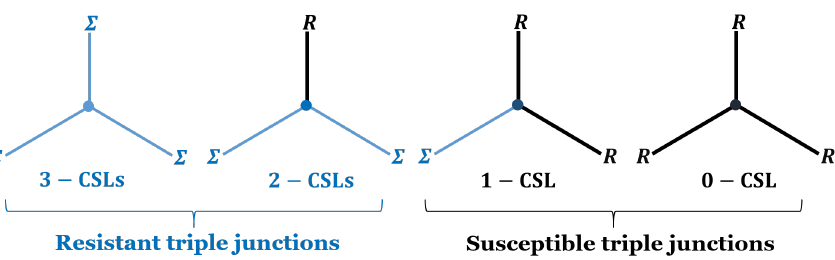
Figure 1. Schematic sketch of two different types of triple junctions in terms of percolation probability: the triple junctions with 3-CSL and 2-CSL are resistant triple junctions, which are expected to block Li percolation; the triple junctions with 1-CSL and 0-CSL are susceptible triple junctions, which are potentially active for the Li plating process. Here, thin blue lines denote CSLs, while bold black lines denote random grain boundaries.